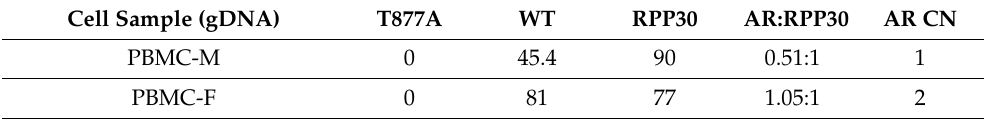
Figure 1. Two-dimensional plot of multiplexed ddPCR AR-Amp-1/T877A assay to detect both the point mutation T877A as well as AR CN. A combination of LNCaP and MFM-233 gDNA was used to represent the various resulting droplet populations. The droplet populations indicated by various colors demonstrate good separation of different variants. Note that the appearance of combination populations is dependent on the amount of DNA input and chance of co-localization of templates within the same droplets. Table 2. AR-Amp-1/T877A assay using gDNA from PBMCs and cell lines as well as mixed LNCaP and PBMC gDNA (concentration unit for each gene: copy/ µ L; M: male; F: